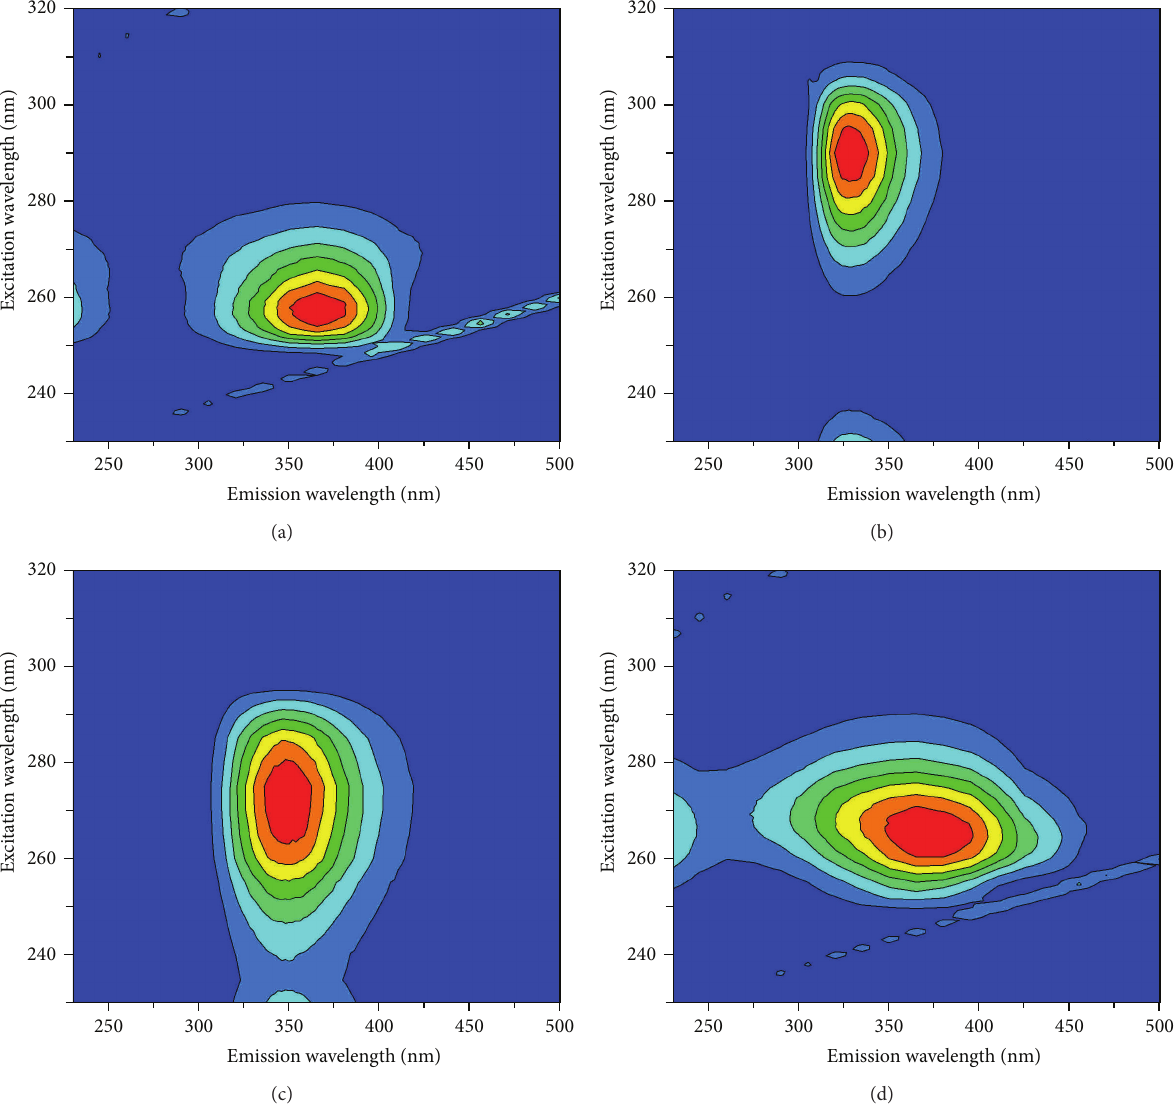
Figure 2: The contours of the excitation-emission matrix fluorescent spectra of pure components of interest and a mixture.